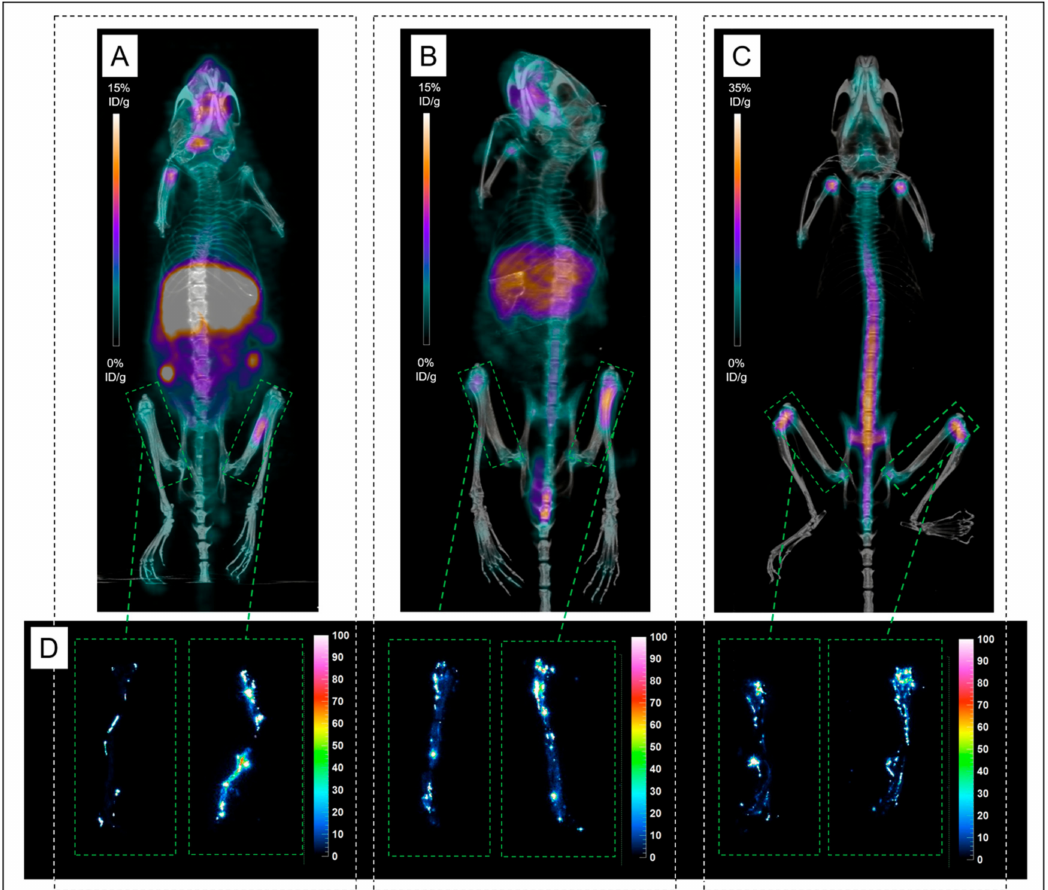
Figure 5. PET imaging and Digital autoradiography acquisitions performed on femurs of Mice imaged with 89 Zr-DFO-9E7.4 or 89 Zr-oxalate. Maximum intensity projections of PET and CT imaging with 89 Zr-DFO-9E7.4 at 24 h post-injection (PI) ( A ) of Mouse 14 showing uptake in the left femur. Maximum intensity projections of PET and CT imaging with 89 Zr-DFO-9E7.4 at 48 h PI ( B ) of Mouse 15 showing uptake in the left femur. Maximum intensity projections of PET and CT imaging with 89 Zr-oxalate at 24 h PI ( C ) of Mouse 19. Digital autoradiography acquisitions performed on femurs of Mice 14, 15 and 19 ( D